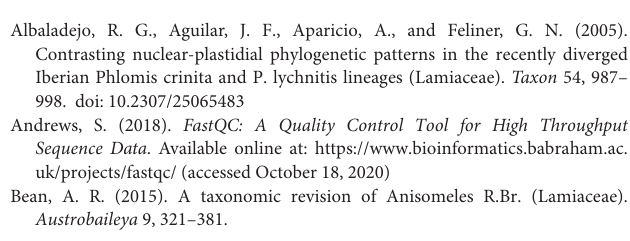
Supplementary Figure 1 | Gene map of the complete chloroplast genome of Paralamium griffithii . Genes inside and outside of the circle are transcribed in the clockwise and counterclockwise directions, respectively. Genes belonging to different functional categories are color-coded. Supplementary Figure 2 | Maximum likelihood phylogeny of Lamiaceae based on 79 chloroplast DNA regions (dataset CP79) of coding regions dataset, ambiguous sites were excluded for analyses. Maximum likelihood bootstrap support (MLBS) are near the branches. A “–” indicates MLBS values < 50%. Supplementary Figure 3 | Phylograms from Bayesian Inference (BI) analyses of Lamiaceae based on concatenated nucleotide sequences of 79 protein-coding genes (dataset CP79), ambiguous sites were excluded for analyses. Bayesian inference posterior probability (BIPP) are near the branches. A “–” indicates BIPP values < 0.8. Supplementary Figure 4 | Maximum likelihood phylogeny of Pogostemoneae based on the nrITS region, ambiguous sites were excluded for analyses. Maximum likelihood bootstrap support (MLBS) are near the branches. A “–” indicates MLBS values < 50%. Supplementary Figure 5 | Phylograms from Bayesian Inference (BI) analyses of Pogostemoneae based on the nrITS region, ambiguous sites were excluded for analyses. Bayesian inference posterior probability (BIPP) are near the branches. A “–” indicates BIPP values < 0.8. Supplementary Figure 6 | Maximum likelihood phylogeny of Pogostemoneae based on the combined dataset of five cpDNA regions ( mat K, rbc L, rps 16, trn H- psb A, and trn L- trn F), ambiguously aligned sites were excluded from analyses. Maximum likelihood bootstrap support (MLBS) are near the branches. A “–” indicates MLBS values < 50%. Supplementary Figure 7 | Phylograms from Bayesian Inference (BI) analyses of Pogostemoneae based on the combined dataset of five cpDNA regions( mat K, rbc L, rps 16, trn H- psb A, and trn L- trn F), ambiguously aligned sites were excluded from analyses. Bayesian inference posterior probability (BIPP) are near the branches. A “–” indicates BIPP values < 0.8. Supplementary Figure 8 | Phylograms from Bayesian Inference (BI) analyses of Pogostemoneae based on the combined dataset of five cpDNA regions ( mat K, rbc L, rps 16, trn H- psb A, and trn L- trn F), under a partitioned strategy model, ambiguously aligned sites were excluded from analyses. Bayesian inference posterior probability (BIPP) are near the branches. A “–” indicates BIPP values < 0.8. Supplementary Table 1 | List of taxa sampled with information related to taxonomy, GenBank accession numbers and references. Supplementary Table 2 | Features of newly sequenced plastome of Paralamium griffithii . Supplementary Table 3 | Excluded ambiguous sites for each